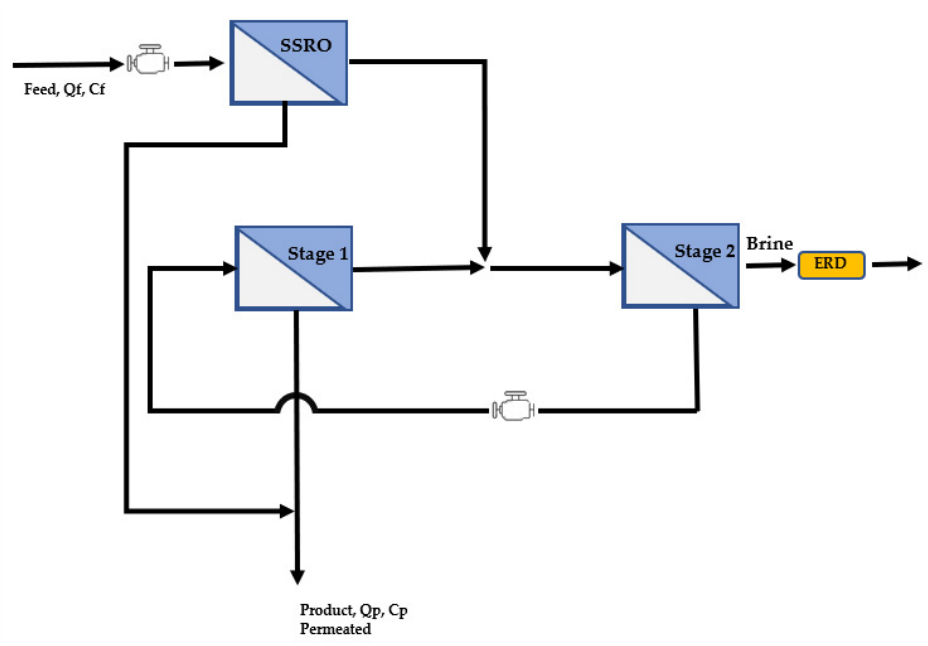
Figure 4. Low-consumption RO system proposed by, source [48].